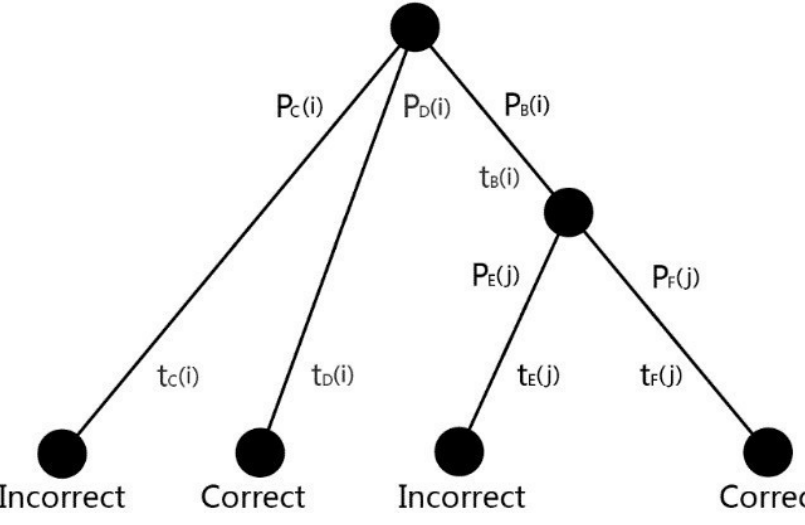
Figure 2. The Standard Tree for Ordered Processes.